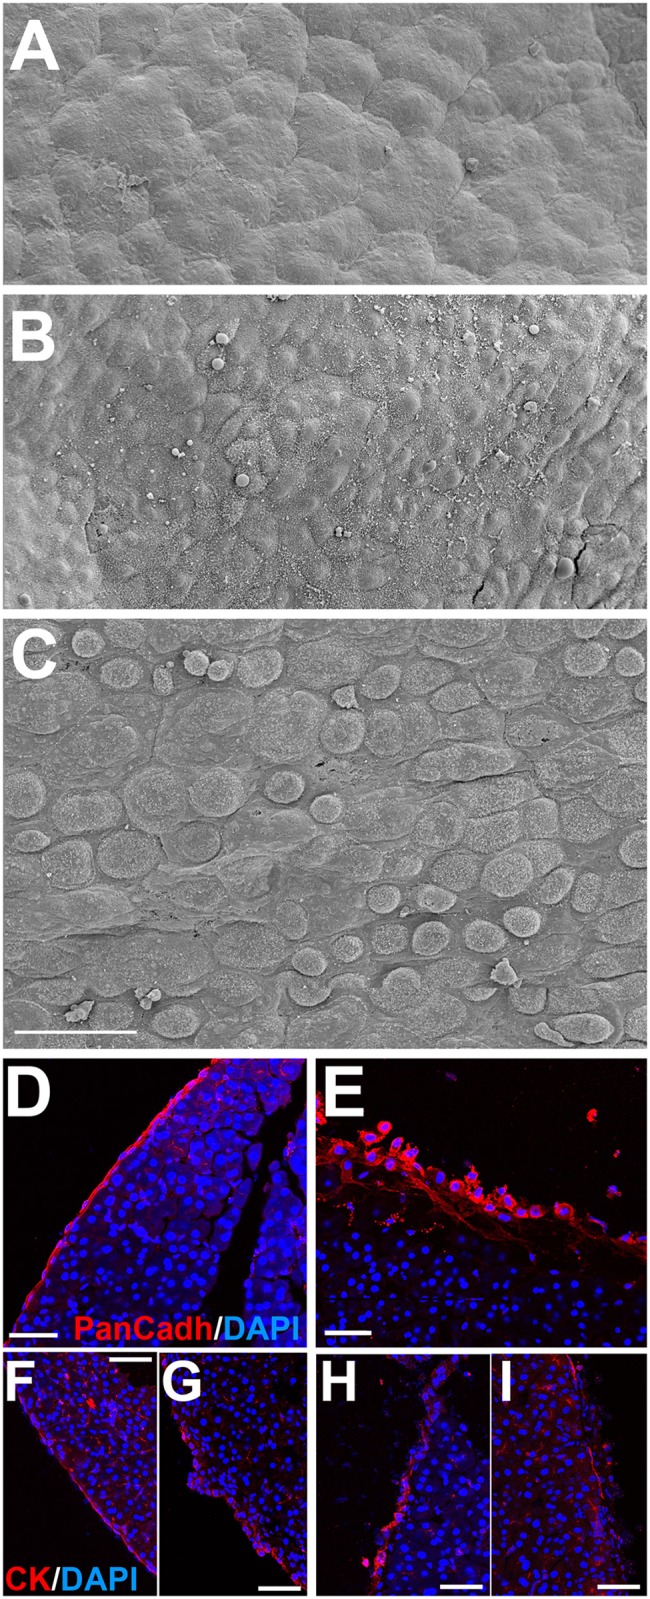
Pancreatic mesothelium is disrupted after WT1 deletion.A. Scanning electron micrography of normal pancreatic mesothelium. B. Pancreatic mesothelium of a control mice (Wt1CreERT2;Wt1flox/+) treated with tamoxifen. C. Pancreatic mesothelium of a mutant mice (Wt1CreERT2;Wt1flox/+) showing reduced adhesion between mesothelial cells. D,E. Disruption of the mesothelium of the mutant mice (E) is shown by pan-cadherin immunolocalization. F,G. Pan-cytokeratin immunolocalization. Different morphologies are observed in the pancreatic mesothelium of these control mice, but mesothelial cells were always forming a continuous cell layer. H,I. Pan-cytokeratin immunolocalization in the mutant mice reveals disruption of the mesothelium. Scale bars: 50 μm.